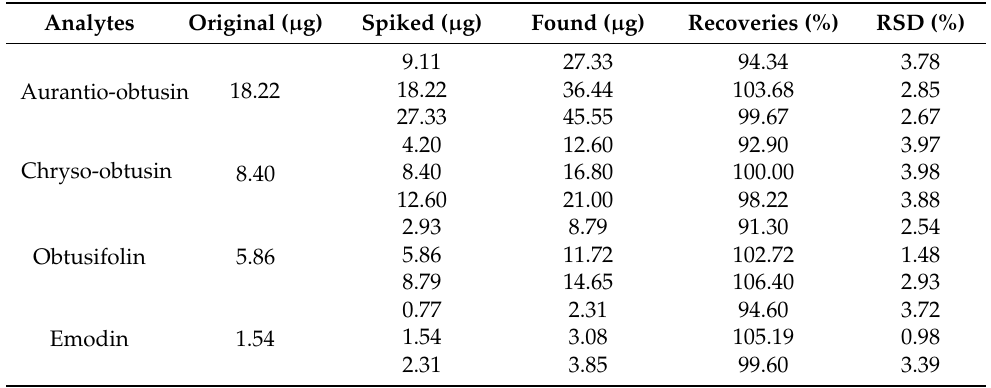
Table 2. The recoveries of four